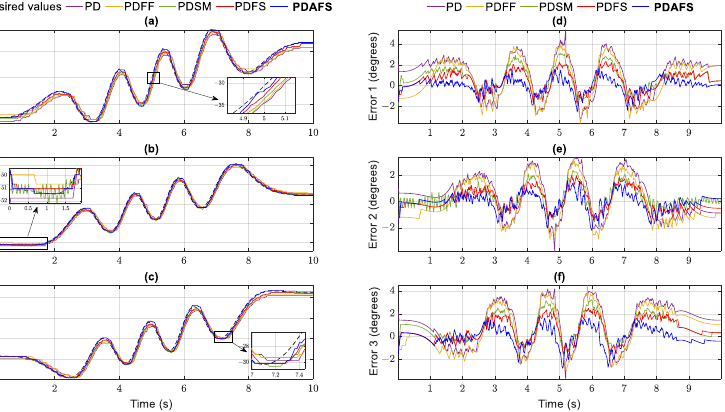
Figure 12. Helix trajectory performance in joint space: ( a ) joint 1; ( b ) joint 2; ( c ) joint 3 and tracking error of joints: ( d ) joint 1; ( e ) joint 2; ( f ) joint 3 in experiment case 1.